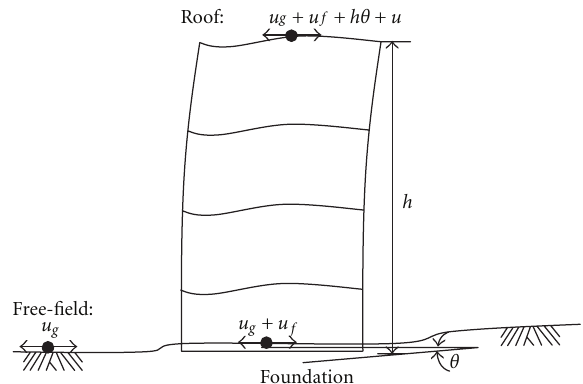
Figure 4: Inputs and outputs for evaluating SSI e ff ects in system identification of buildings